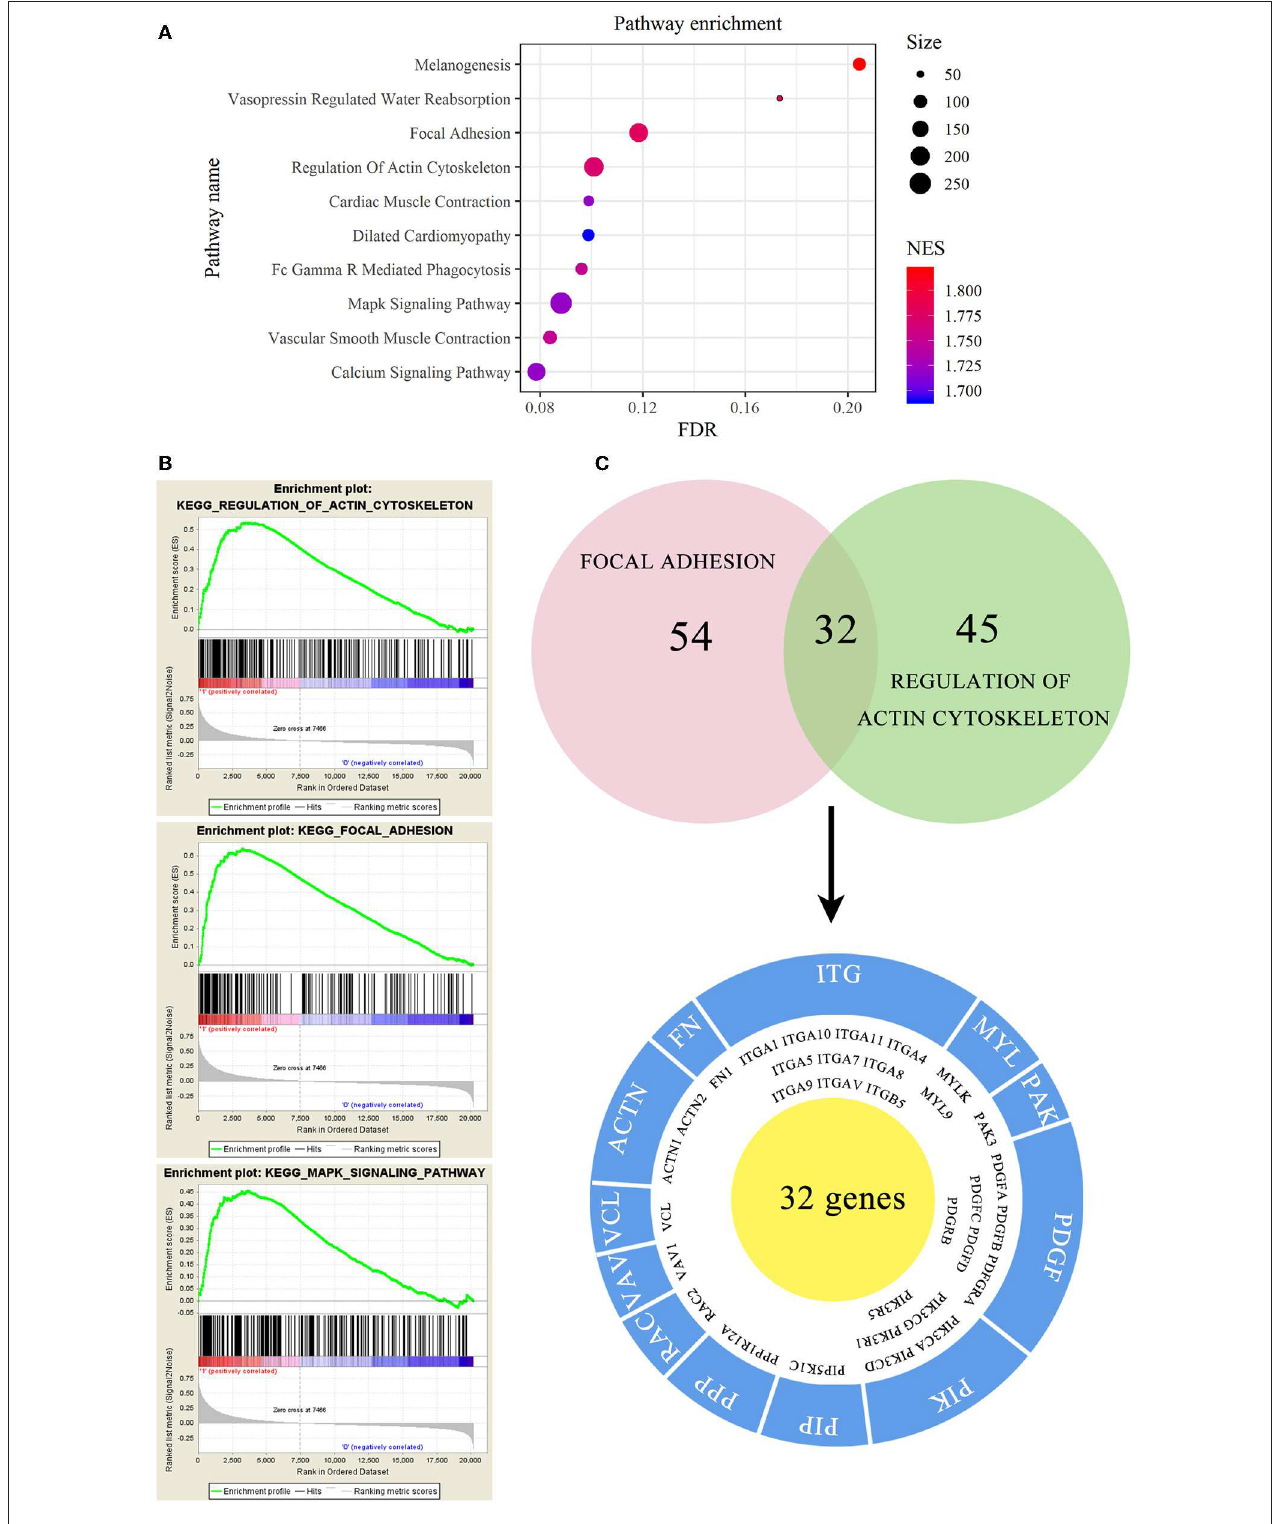
FIGURE 7 | Functional enrichment analysis of EMCN in diffuse type GC. EMCN high expression group-enriched signaling pathways were analyzed using KEGG (A) and GSEA (B) . Venn diagram analysis showed coexpression genes in focal adhesion and regulation of actin cytoskeleton and mainly focused on integrin family (C) .